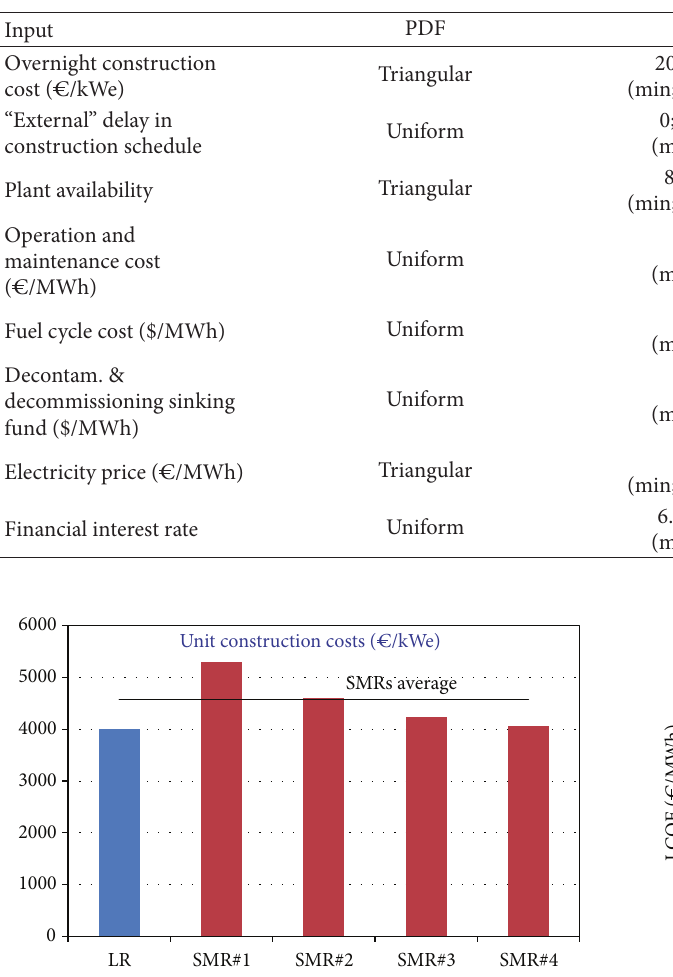
Table 2: Scenario input data for Monte Carlo simulation.